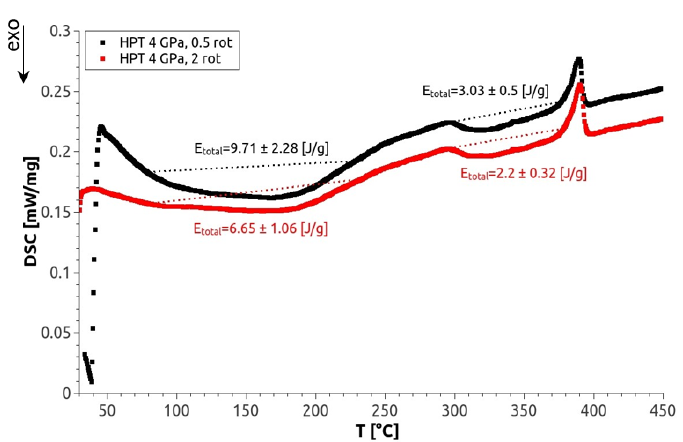
Figure 20. A typical heat flow curve as function of the temperature, for HPT ‐ processed Mg5Zn0.3Ca (black curve—0.5 rotations, red curve—2 rotations) showing two exothermal peaks I and II. The stored energies E total of the HPT ‐ induced defects were evaluated from the areas of the peaks.